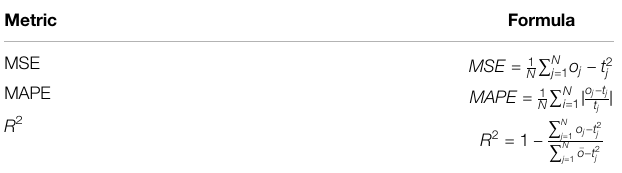
TABLE 2 | Prediction performance evaluation